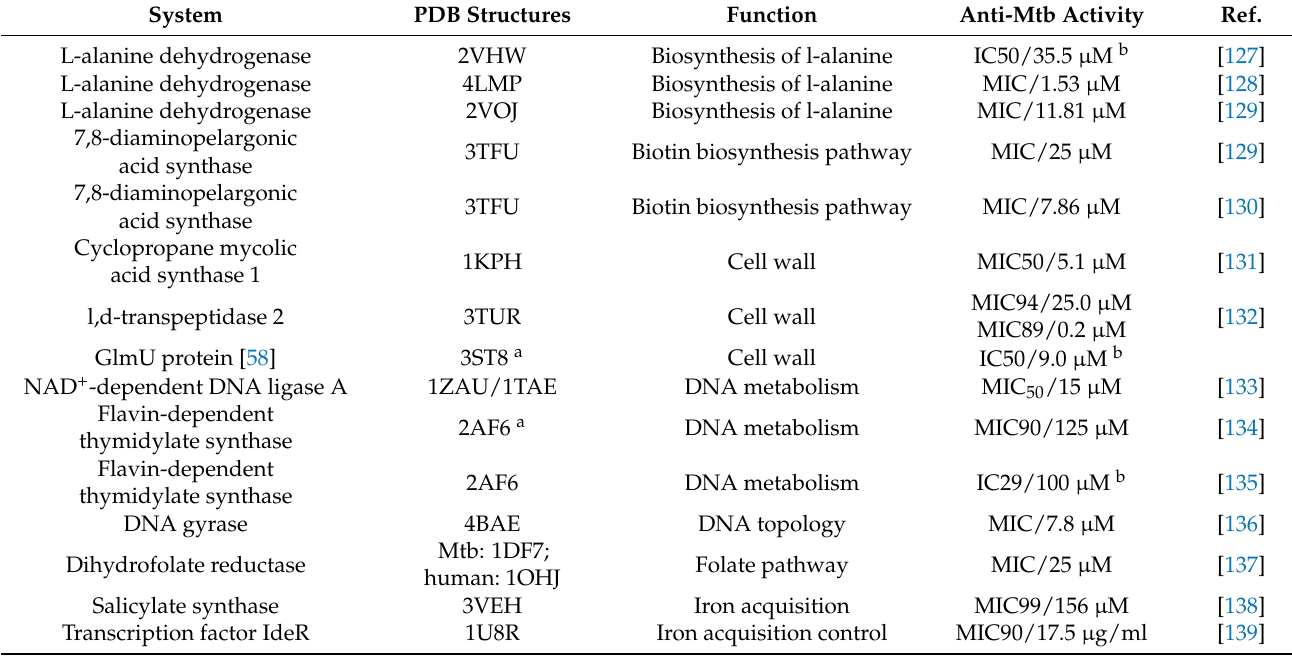
Table 4. Successful SBVS approaches on anti-Mtb and activities of the best compounds *. A summary of Mtb pathways is available in the supporting